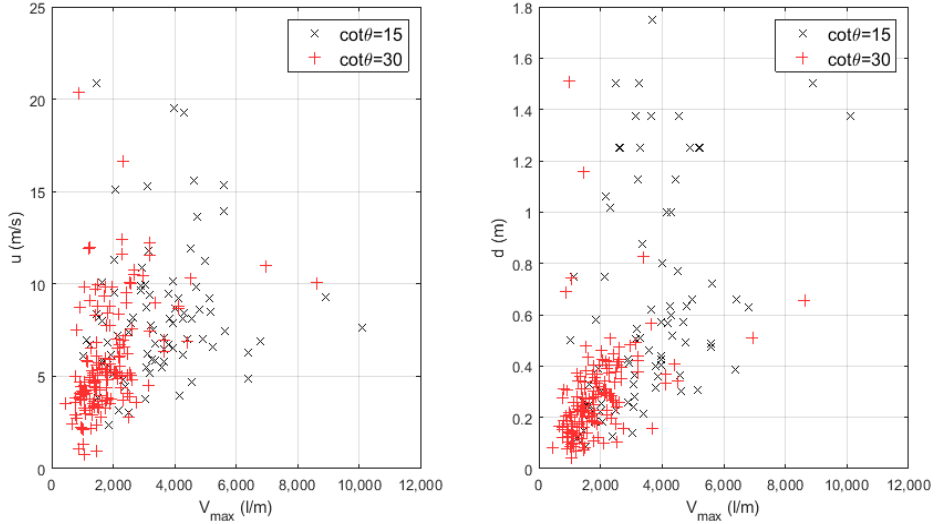
Figure 11. Variation of overtopping flow velocity and depth with maximum individual overtopping volume (dimensions in prototype) for two different foreshore slopes.